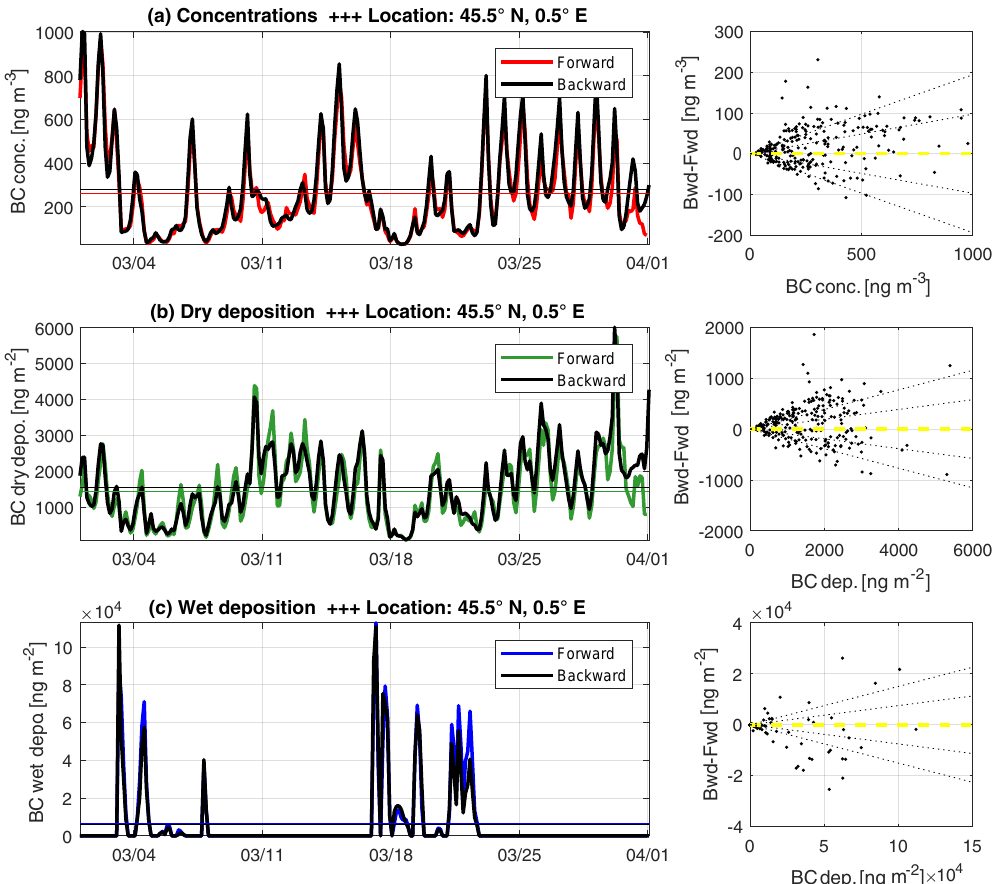
Figure 5. Average 3-hourly BC concentrations in the lowest 100m (a) , BC dry deposition (b) and BC wet deposition (c) from forward (red, green, blue) and backward (black) simulations for the receptor point A (shown in Fig. 3) for March 2012. The two horizontal lines show the mean value of the forward and the backward run for the whole period. Panels on the right-hand side show the difference between the backward and the forward simulation vs. values from BC concentration/deposition of the average of backward and forward